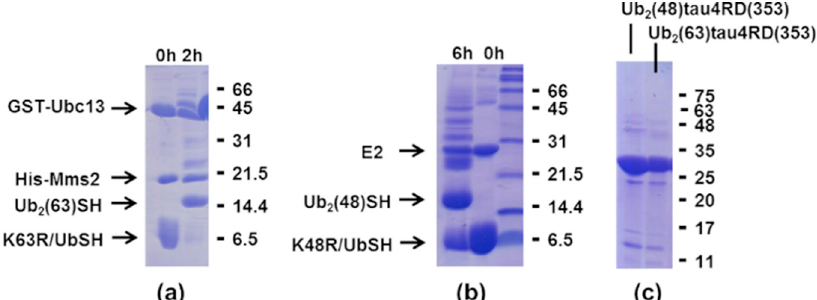
Figure 3. SDS-PAGE showing the enzymatic reaction to obtain the Ub 2 (63)-SH ( a ) or Ub 2 (48)-SH ( b ) di-ubiquitin molecules. In ( c ), the purified Ub 2 (48)tau4RD(353) and Ub 2 (63)tau4RD(353) are shown.